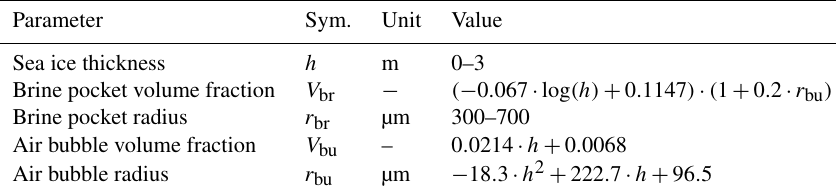
Table A1. Physical parameters of ice. In generating the sea ice thickness, a truncated-normal distribution ( µ = 0 . 03; σ = 1 . 5) was used to ensure an adequate amount of thin ice in the SD. The brine pocket radius conforms to a Tukey lambda distribution (with λ = 0.5).